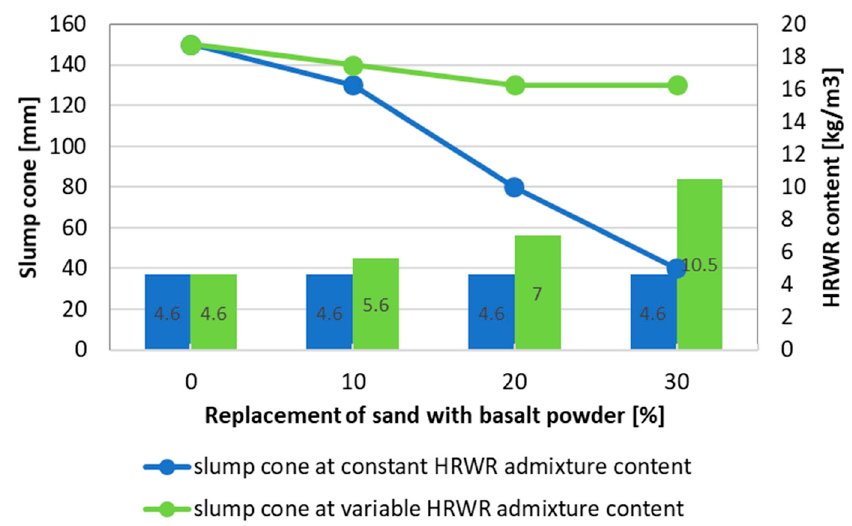
Figure 6. Change of the value of concrete mix slump cone test as a function of basalt dust content at constant and variable HRWR admixture content.